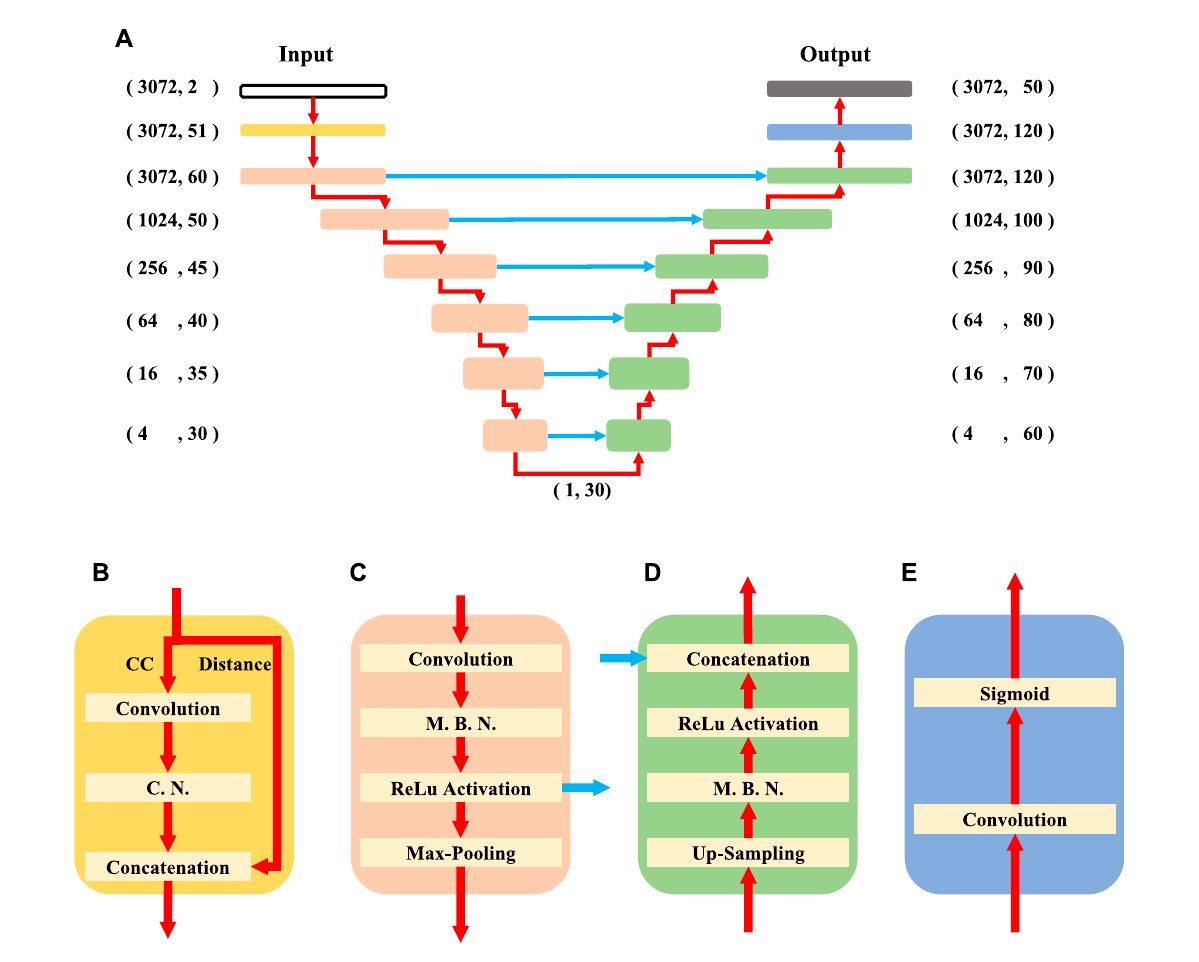
FIGURE 5 The structure of Surf-Net (A) and the large-kernel convolution (B) , down-sampling (C) , up-sampling (D) and output (E) units. The red arrows present the data fl ow, and the blue ones are skipping connections. In (A) , the ( n , m ) combination next to a speci fi c unit shows the data fl ow shape, where n and m are the numbers of sampling points and channels, respectively. In (B) , the input data fl ow is fi rst divided into the CC and distance channels. The convolution and channel normalization layers are then sequentially applied to the CC channel. The two divided fl ows are fi nally concatenated together. The C. N. and M. B. N. are short for the channel normalization layer and momentum batch normalization layer, respectively. All the convolution layers are depthwise